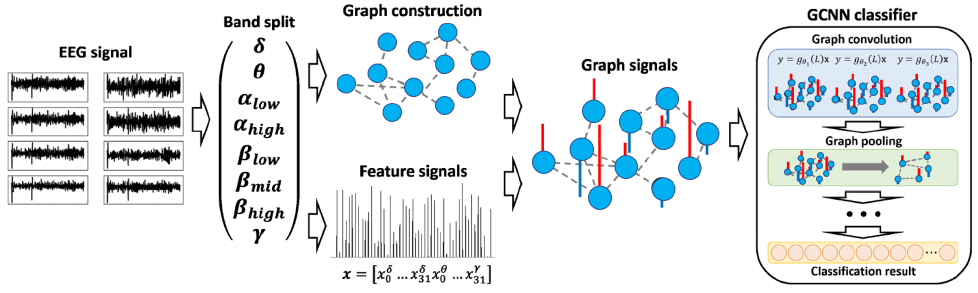
Figure 6. Features are extracted from EEG signals to construct a graph-based architecture and classify mental states. Image adapted from